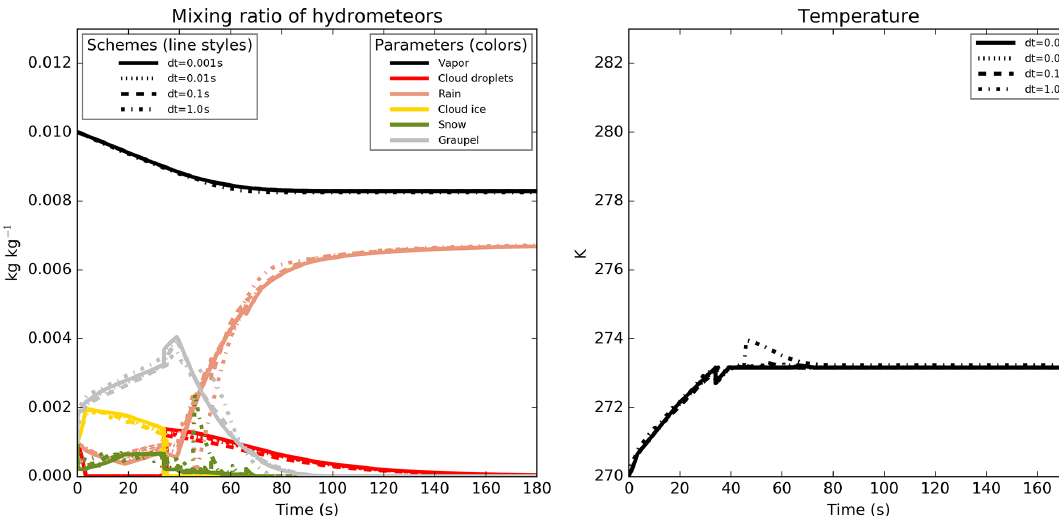
Figure 7. Same as Fig. 1 but using smaller time steps between 0.001 and 1s.